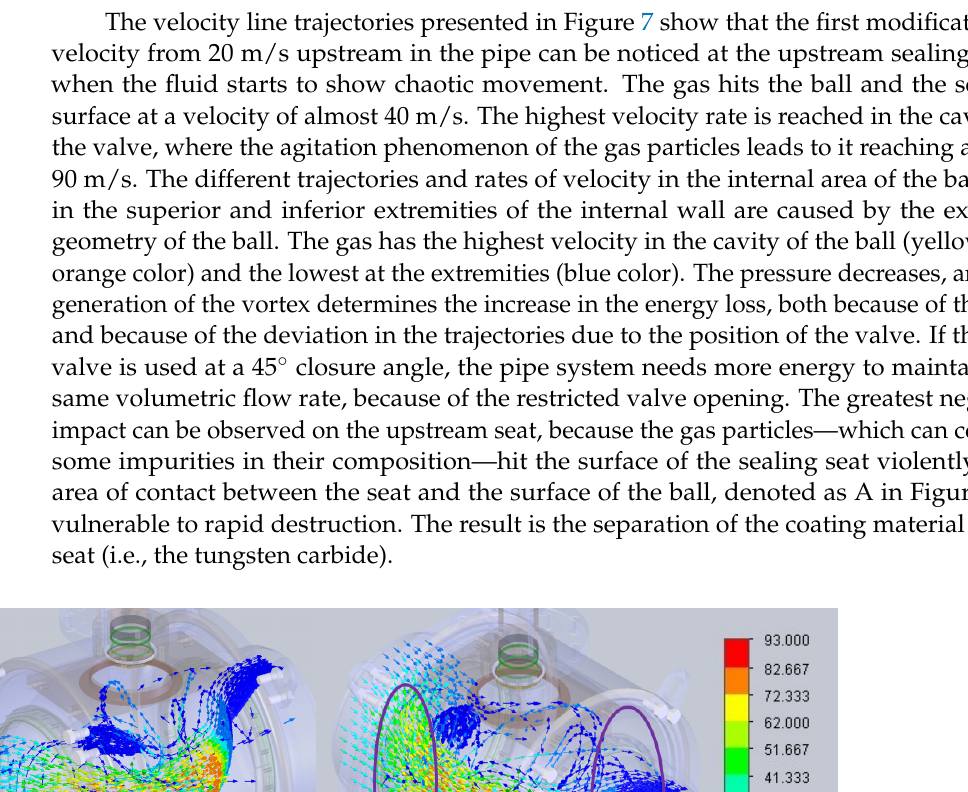
( b ) Figure 8. Pressure line trajectories for a 60° closure angle: ( a ) upstream view; ( b ) downstream view. Figure 9 indicates that the initial gas velocity is amplified in the zone where the first loss of pressure occurs, reaching almost 55 m/s. Some gas particles enter the cavity by passing between the internal wall of the principal body and the external wall of the ball,